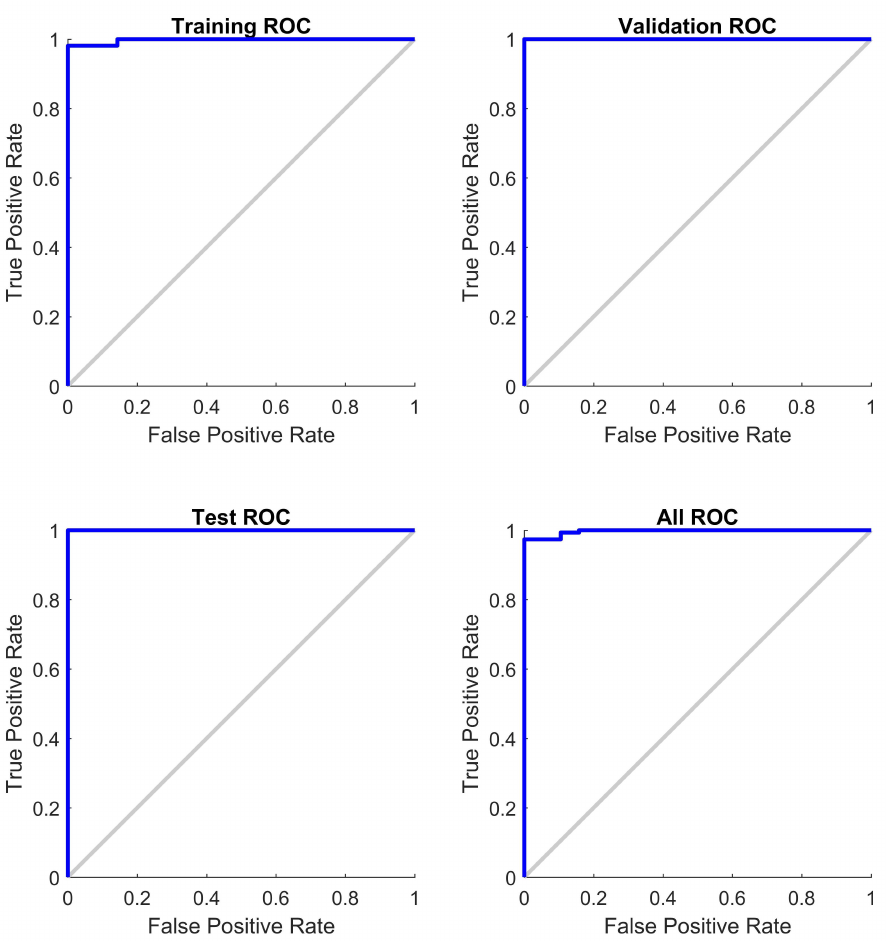
Figure 2. ROC sample curve for one of the